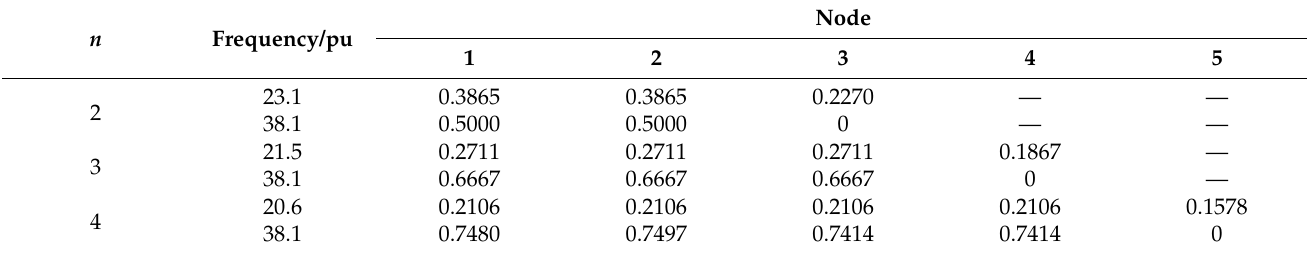
Table 2. The participation factor of each node when the number of grid-connected inverters is